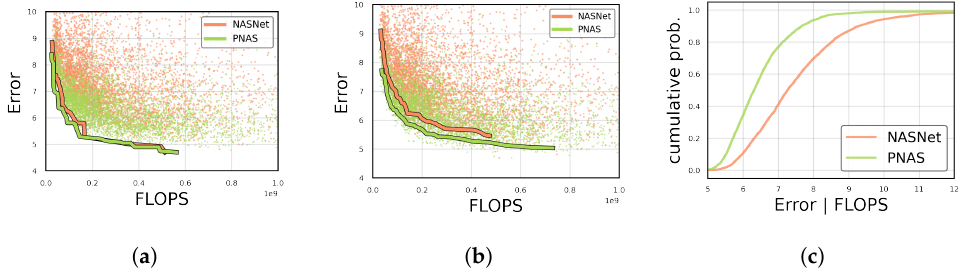
Figure 1. ( a ) Comparing the best performing models out of 5000 generated ones for the PNAS and NASNet families shows that they can achieve similar accuracies, but, in general, PNAS will provide good models much faster, as can be seen in the normalized error EDF ( c ), which is also implicitly captured when creating accuracy/complexity curves ( b ) through random sampling with only 130 samples.